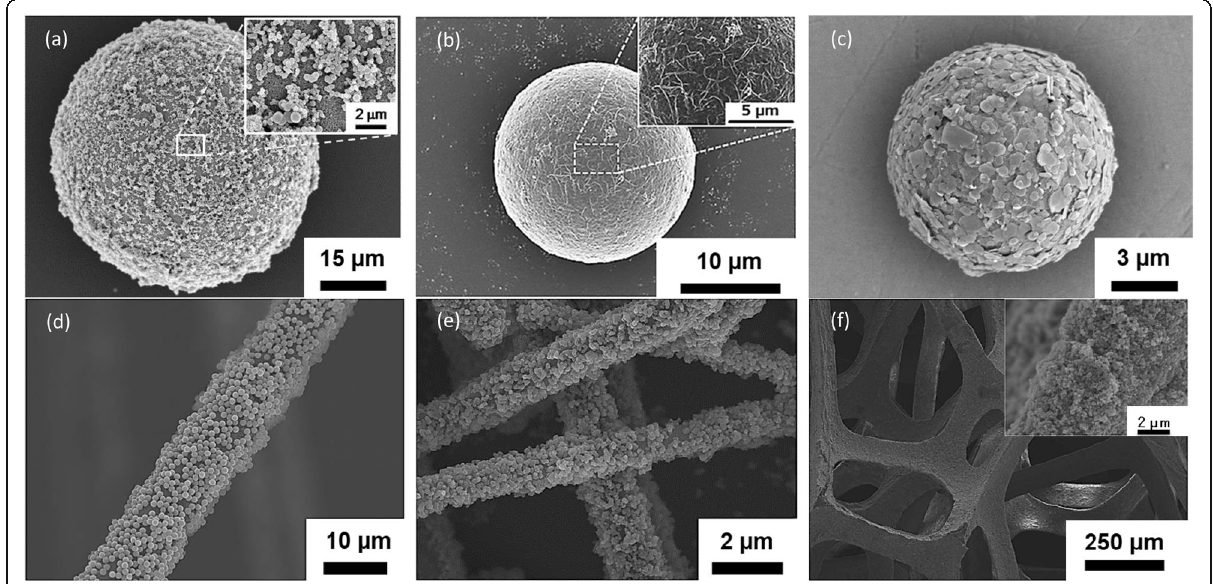
Fig. 8 SEM images of the nano and micro-assembled composites obtained by EA method. a carbon microspheres-Al 2 O 3 , b CNT-PMMA, c BN-SiO 2 , d SiO 2 - carbon fiber, e